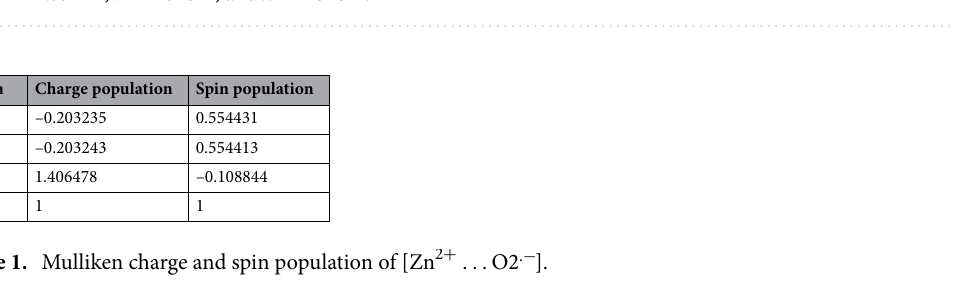
Figure 6. The dependence of the MT density of the administration of Zn (with zero nuclear spin) [Red] and 5 67 Zn (with nuclear spin of I B = − 2 ) [Blue] on the strength of applied magnetic field based on the RP complex of [ TrpH . + . . . O2 . − ]. The geomagnetic field is 0.05 mT. The magnetic field modulates rate k p for a A = 1.6046 mT,